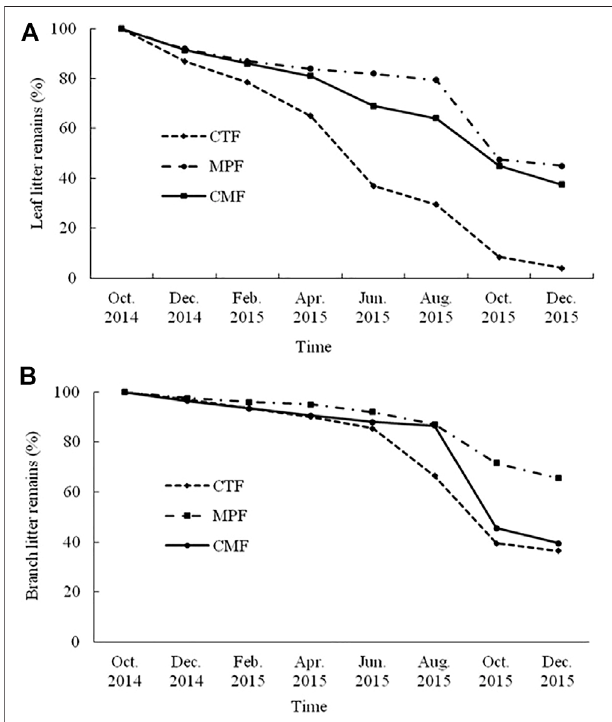
FIGURE 3 | The decomposition process of leaf litter (A) and branch litter (B) in the three examined forest types. CTF, camphor tree forest; MPF, Masson pine forest; CMF, camphor tree and Masson pine mixed